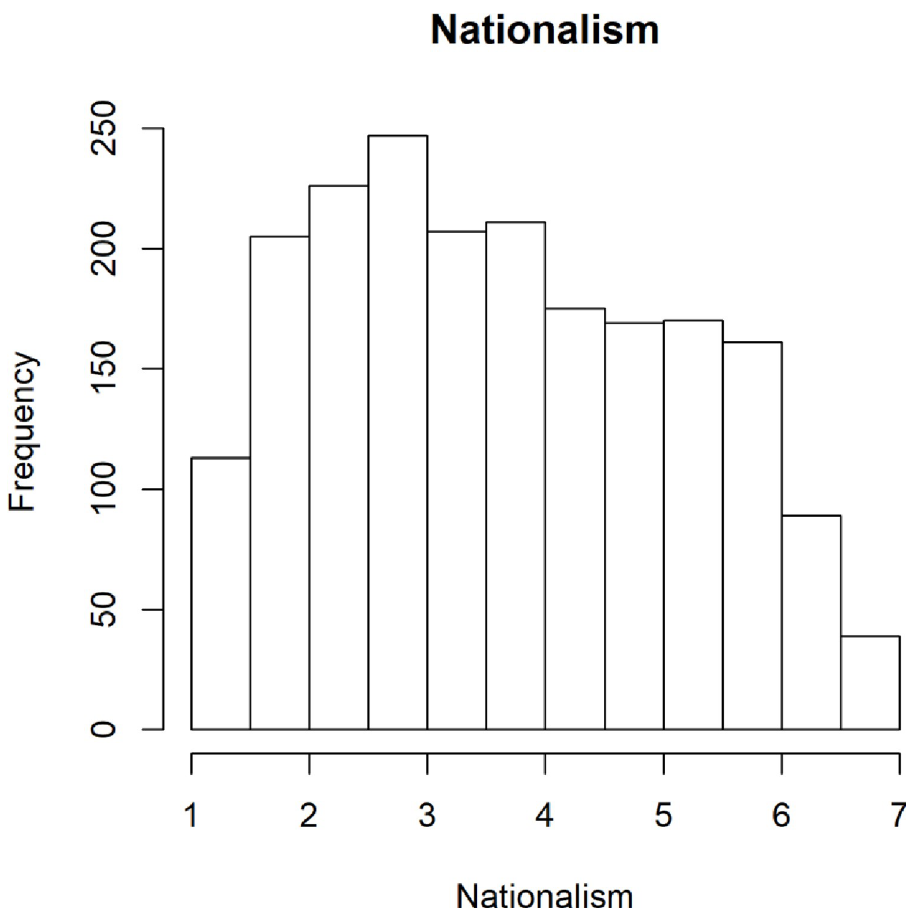
Fig 6. Distribution of nationalist